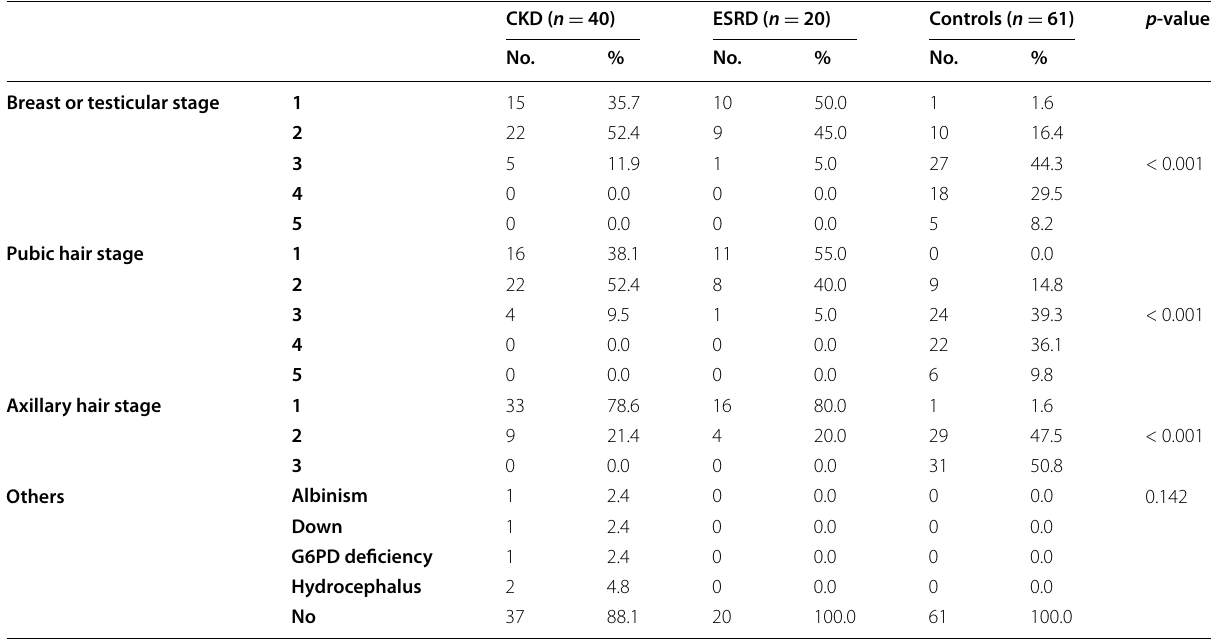
CKD chronic kidney disease, ESRD end-stage renal disease, G6PD glucose-6-phosphate